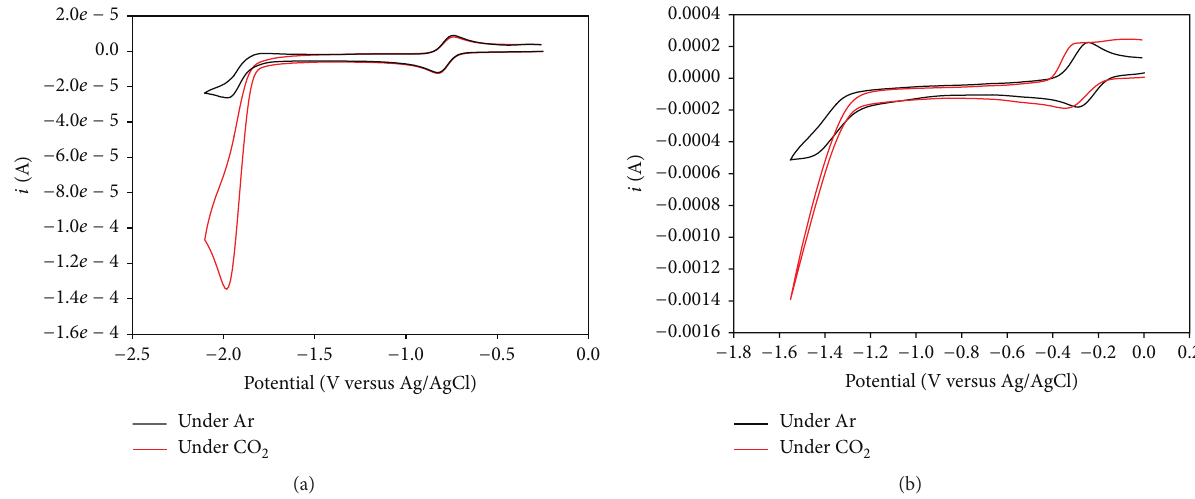
Figure 4: Cyclic voltammetry of 0.20 mM Co(TPP)Cl in 0.1M [Bu 4 N][BF 4 ]-95% MeCN+ 5% DMF, scan rate 100mVs −1 (a) at a vitreous carbon electrode and (b) at illuminated 1–10ohmcm −1 p-type Si electrode.